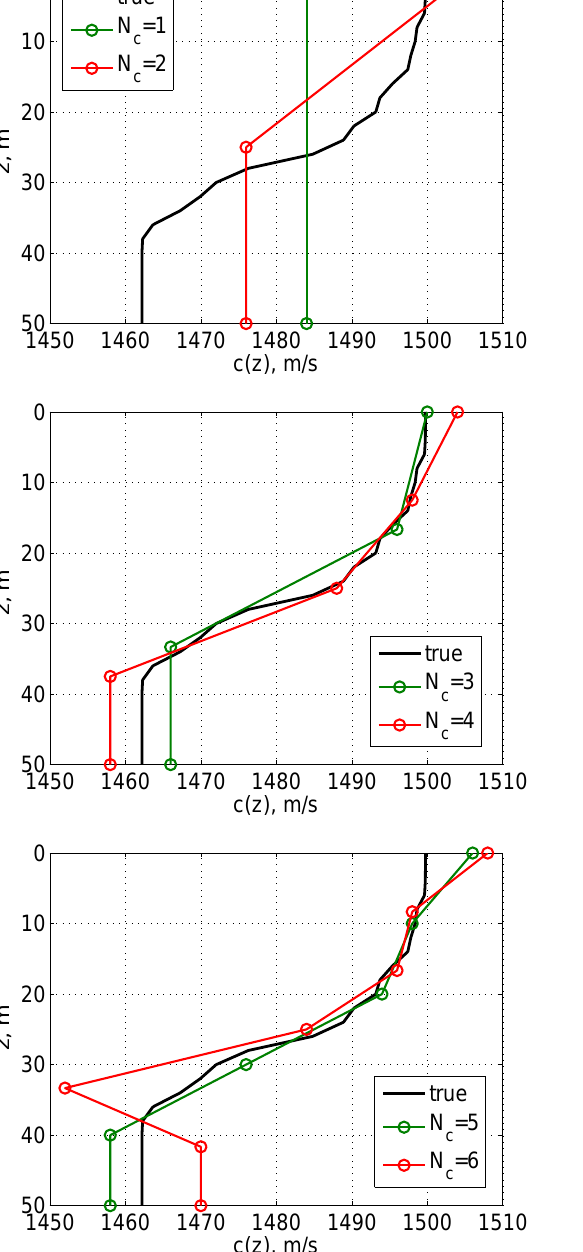
Figure 1: Estimated sound speed profiles c ( z ) for N c = 1, 2, . . . , 5 and the true one (black line on all panels). Top panel: N c = 1 (green line) and N c = 2 (red line). Middle panel: N c = 3 (green line) and N c = 4 (red line). Bottom panel: N c = 5 (green line) and N c = 6 (red line).